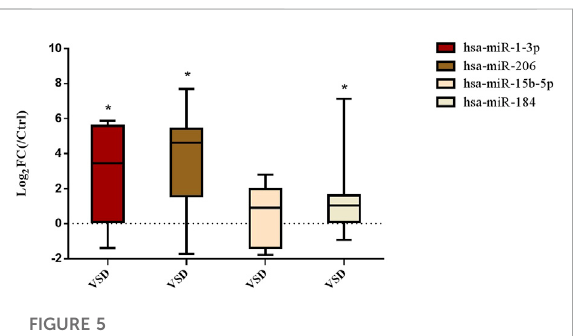
FIGURE 5 Expression of amniotic fl uid-derived DE-microRNAs in clinical samples. (Compared with NC group: * p < 0.05. n = 7)